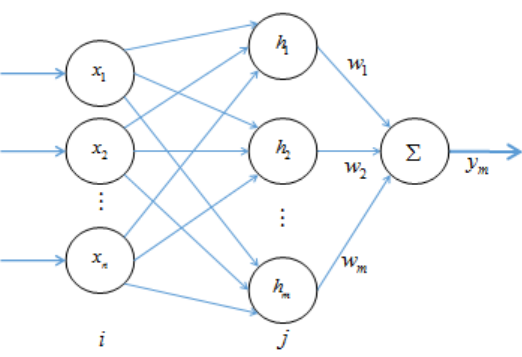
Figure 1. The structure of the radial basis function (RBF) neural network.